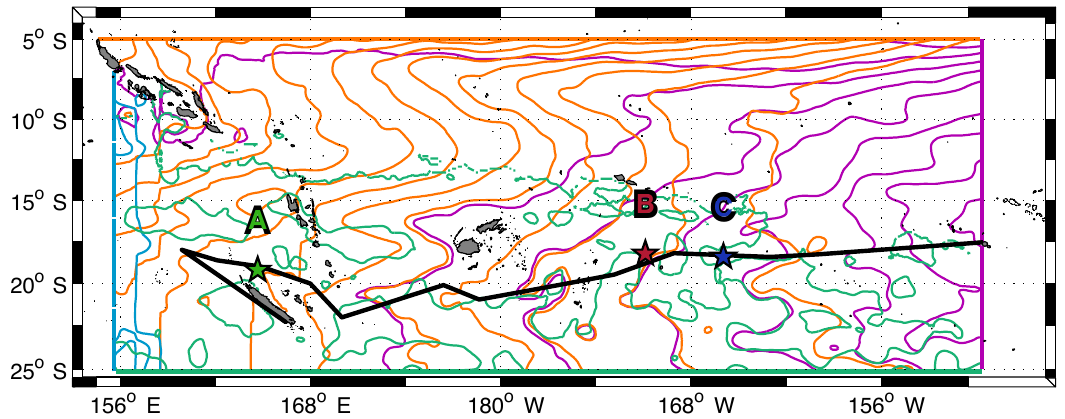
Figure A2. Forward stream functions computed for a 10-year period with the total altimetry-derived product from CLS. Each streamline’s colour corresponds to the initial section of numerical particles: north section (orange lines), east section (purple lines), south section (green lines) and west section (magenta lines). The ship track and locations of OUTPACE LD stations are indicated with the black line and coloured stars as in Fig. 1.